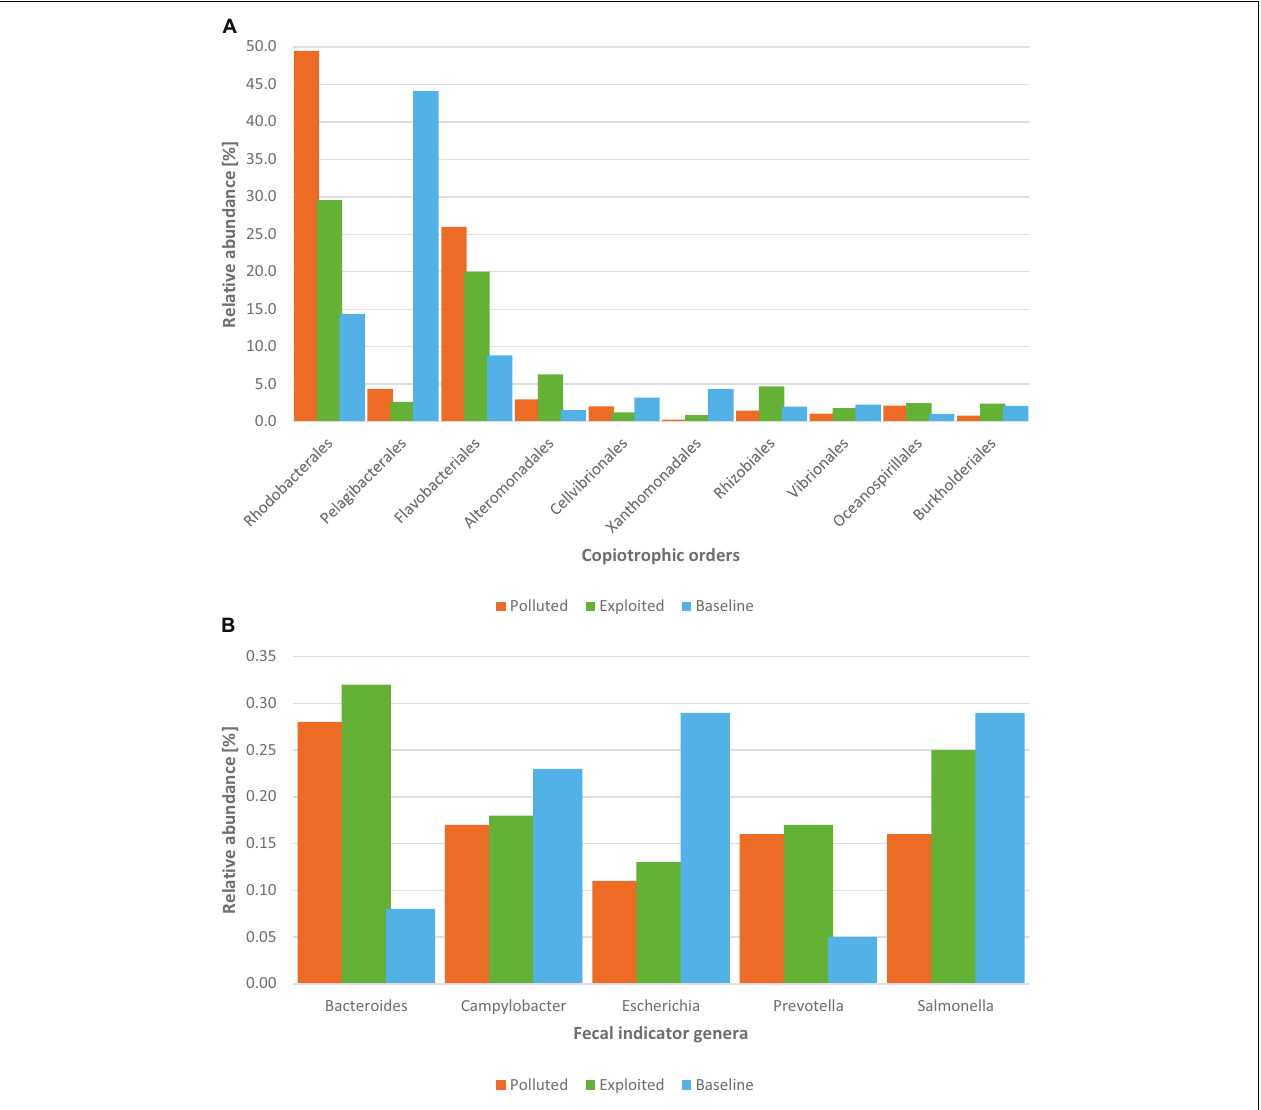
FIGURE 4 | Distribution of (A) the top ten most abundant orders of the copiotrophic phyla (Proteobacteria and Bacteroidetes), and (B) distribution of common FIB genera from metagenomes of near-coral seawater and sediment samples from Kenyan reefs at the national marine parks classified as “polluted” (Bronze; Mombasa), “exploited” (Olive; Malindi) and “baseline” (Sky;